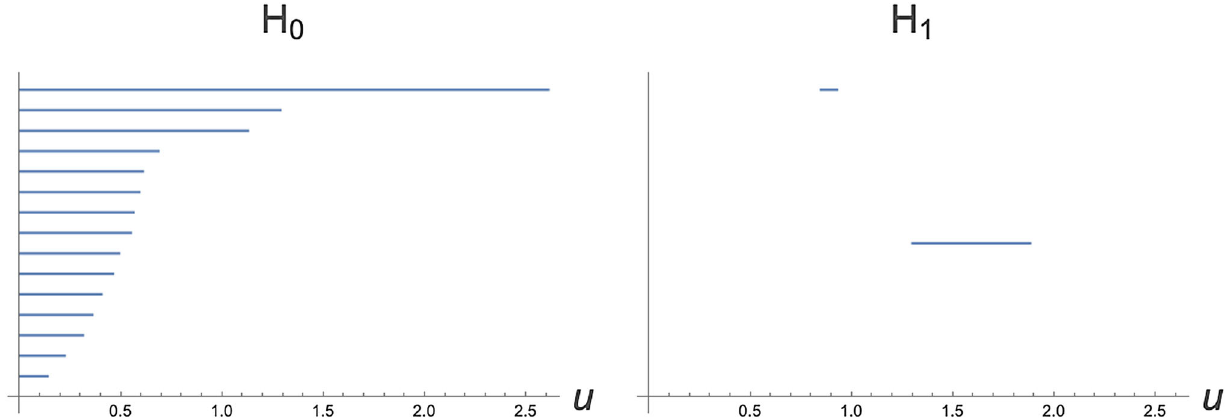
Fig. 11 An example of barcode diagrams. The example is obtained by analyzing a configuration φ i a ( i = 1 , 2 ,..., R ) generated by the actual Monte Carlo simulation for N = 4, R = 15, and k = 0 . 01. The pres-